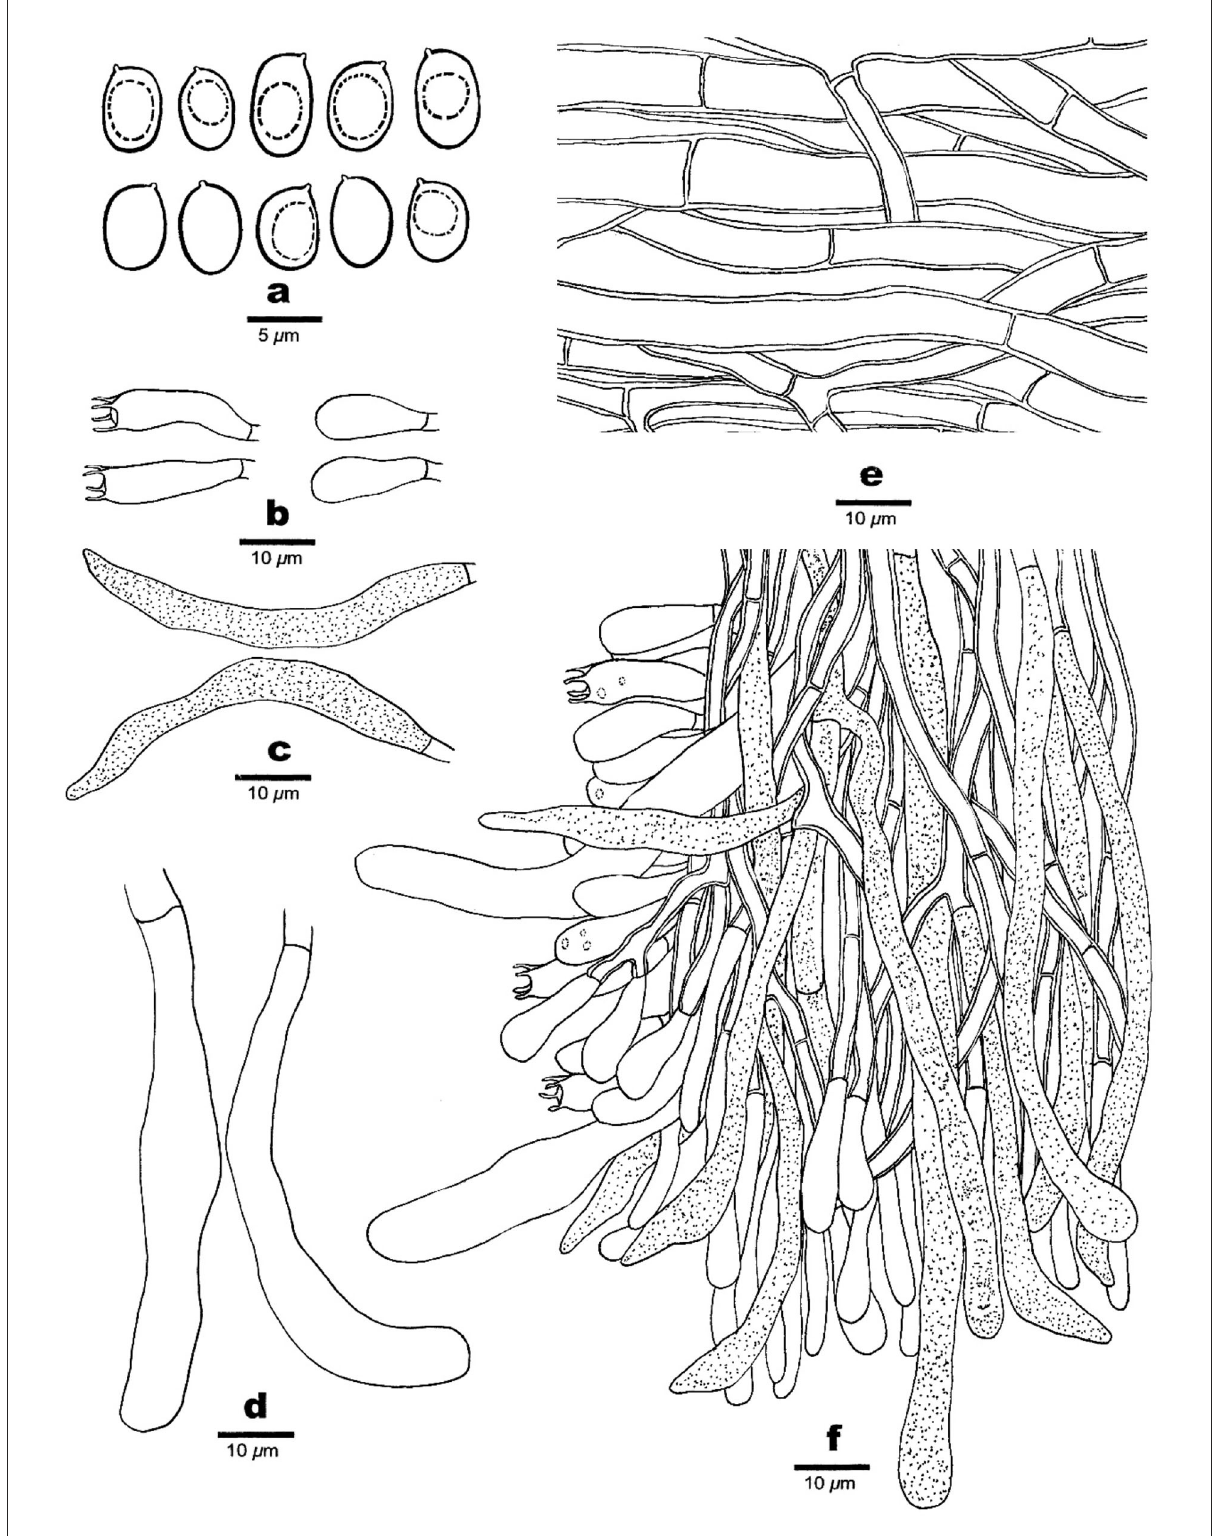
FIGURE5 Microscopic structures of Phaeolus yunnanensis (drawn from the holotype, Dai 20426). (a) Basidiospores. (b) Basidia and basidioles. (c) Gloeocystidia. (d) Cystidia. (e) Hyphae from context. (f) A section from tube